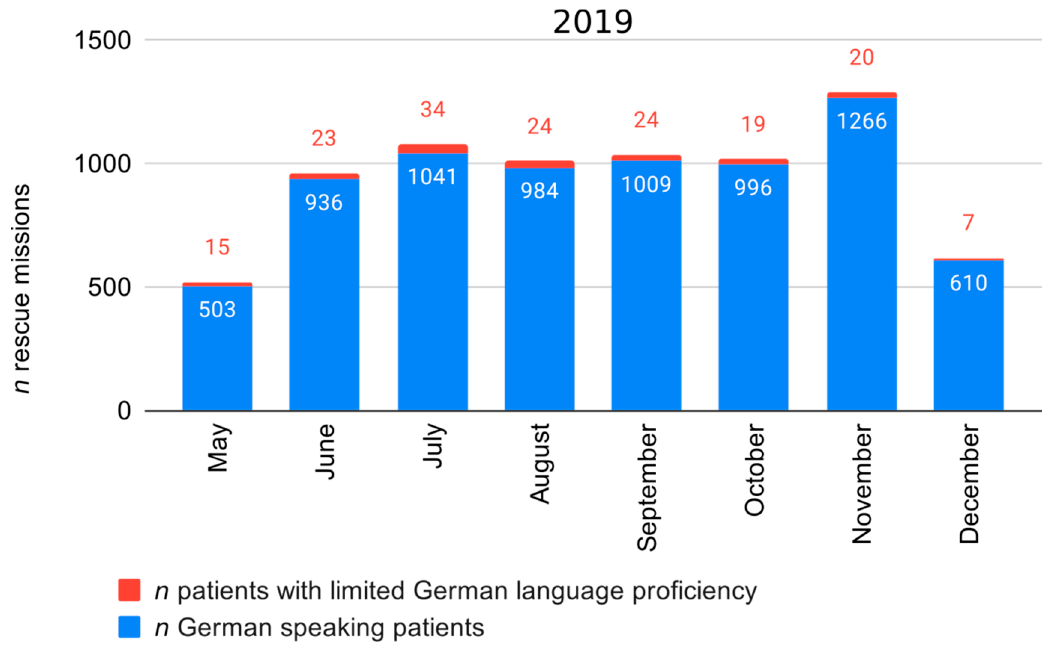
Figure 2. Rescue operations during the study period in 2019.